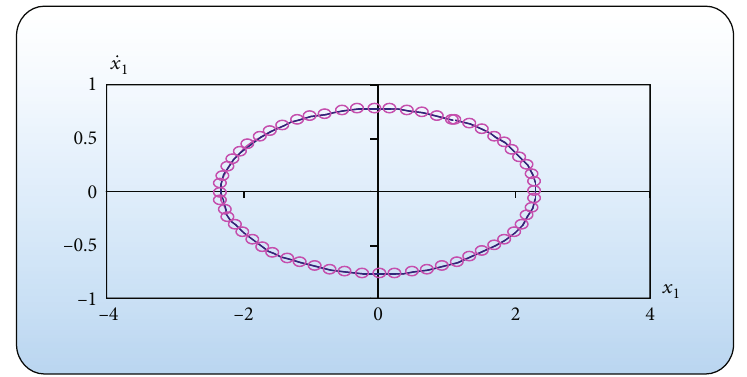
Figure 8: The stability of the numerical solution _ x